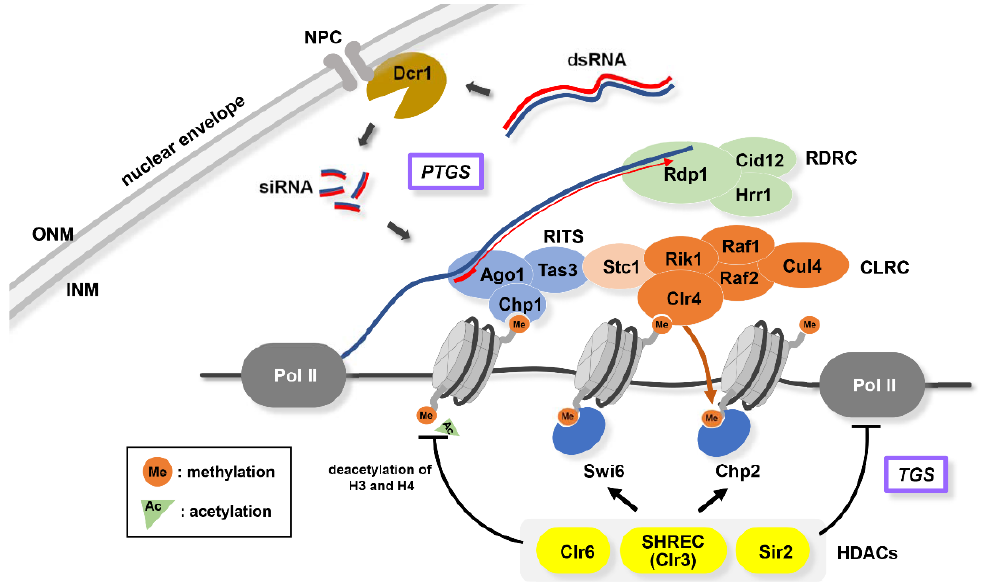
Figure 2. Principles of heterochromatin formation. RNAi-mediated PTGS (post-transcriptional gene silencing) and HDAC-mediated TGS (transcriptional gene silencing). PTGS involves Dicer (Dcr1) located at the NPC; RITS (RNA-induced initiation of transcriptional silencing) complex consist of Ago1, Chp1, and Tas3; RDRC (RNA-dependent RNA polymerase complex); CLRC (Clr4 methyltransferase complex) consist of Clr4, Rik1, Cul4, Raf1, and Raf2. TGS involves HDACs (Clr6, SHREC, and Sir2) and HP1 (Swi6 and Chp2).